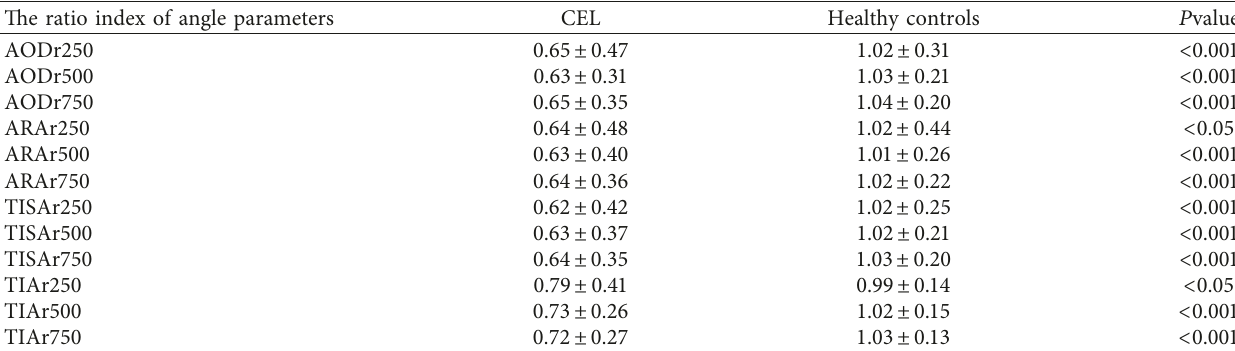
Table 3: Comparison of the ratio index of different angle parameters in CEL patients with healthy controls (mean ± SD). The ratio index of angle